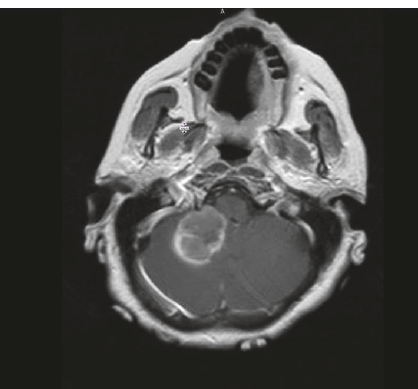
Figure 1: T1 weighted MRI of brain showing right cerebellar lesion.